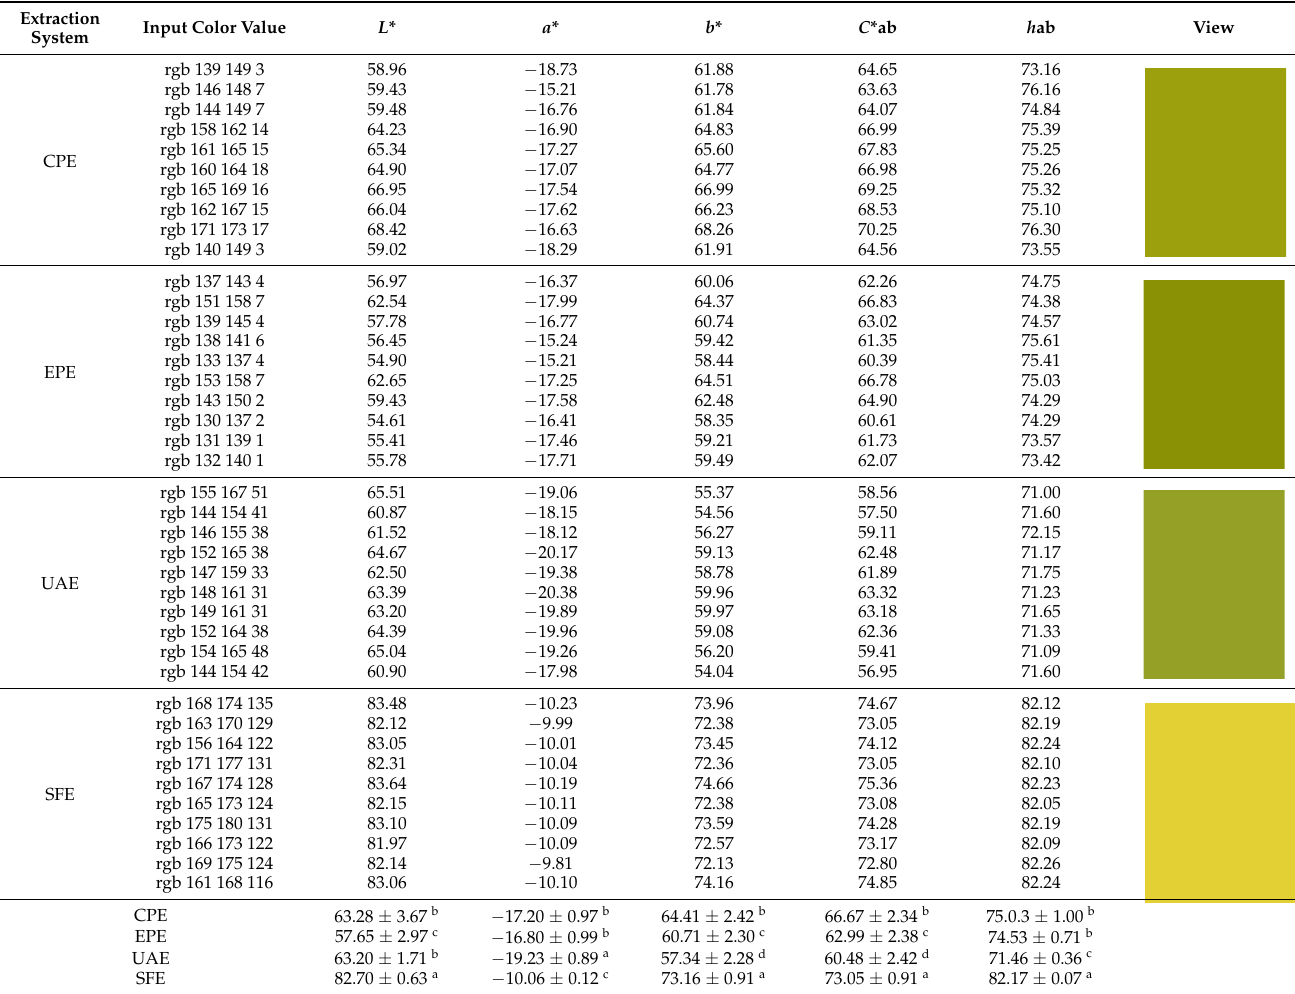
Table 3. Chromatic properties of the sinami oils that were obtained using the four extraction systems.